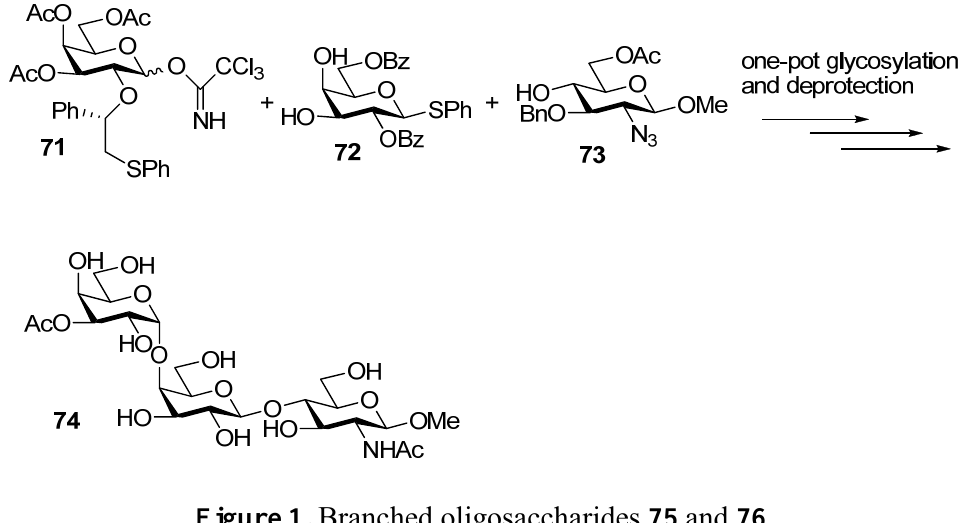
Scheme 12. One-pot two-step synthesis of trisaccharide 74 .